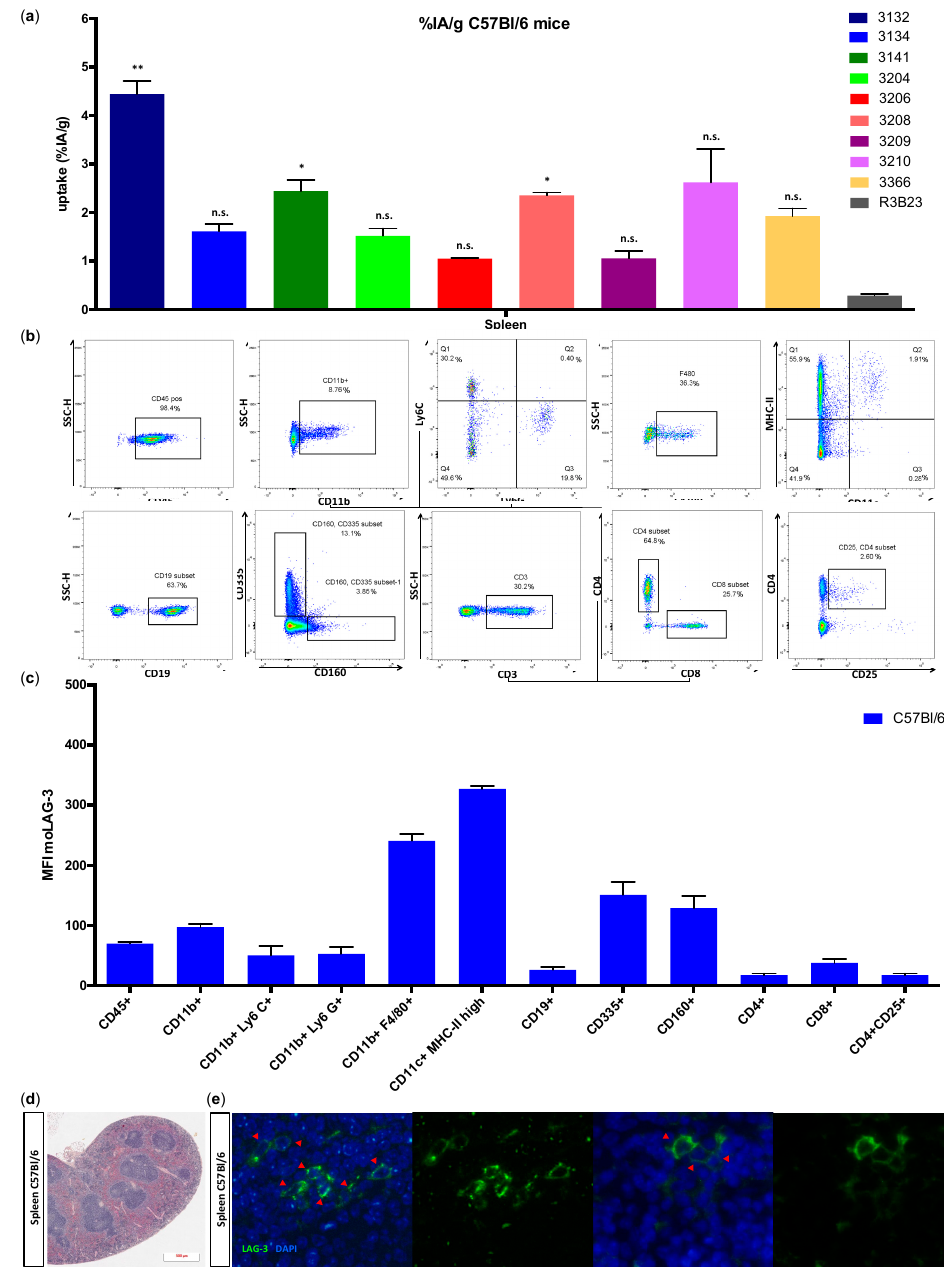
Figure 4 . Ex vivo analysis of immune cell populations within the spleen of C57BL/6 mice. ( a ) Uptake Figure 4. Ex vivo analysis of immune cell populations within the spleen of C57BL / 6 mice. ( a ) Uptake of of the radiolabeled Nbs in the spleen 80 min after injection of naive C57BL/6 mice. The graph the radiolabeled Nbs in the spleen 80 min after injection of naive C57BL / 6 mice. The graph summarizes the results of three mice as mean ± SD ( n = 1). ( b ) Flow cytometry gating for single cell suspensions prepared from isolated spleens. The data shown are representative for three independent mice ( n = 1). ( c ) HES staining of FFPE spleen sections. The data shown are representative for three independent mice ( n = 1). ( d ) Expression of moLAG-3 (MFI) on di ff erent immune cell subsets analyzed by flow cytometry. The graph summarizes the results of three mice as mean ± SD ( n = 1). ( e ) Immunofluorescence microscopy on a spleen section, stained with moLAG-3 (green) and DAPI (blue). The red arrows show moLAG-3 expressing cells. The data shown are representative for three independent mice ( n =